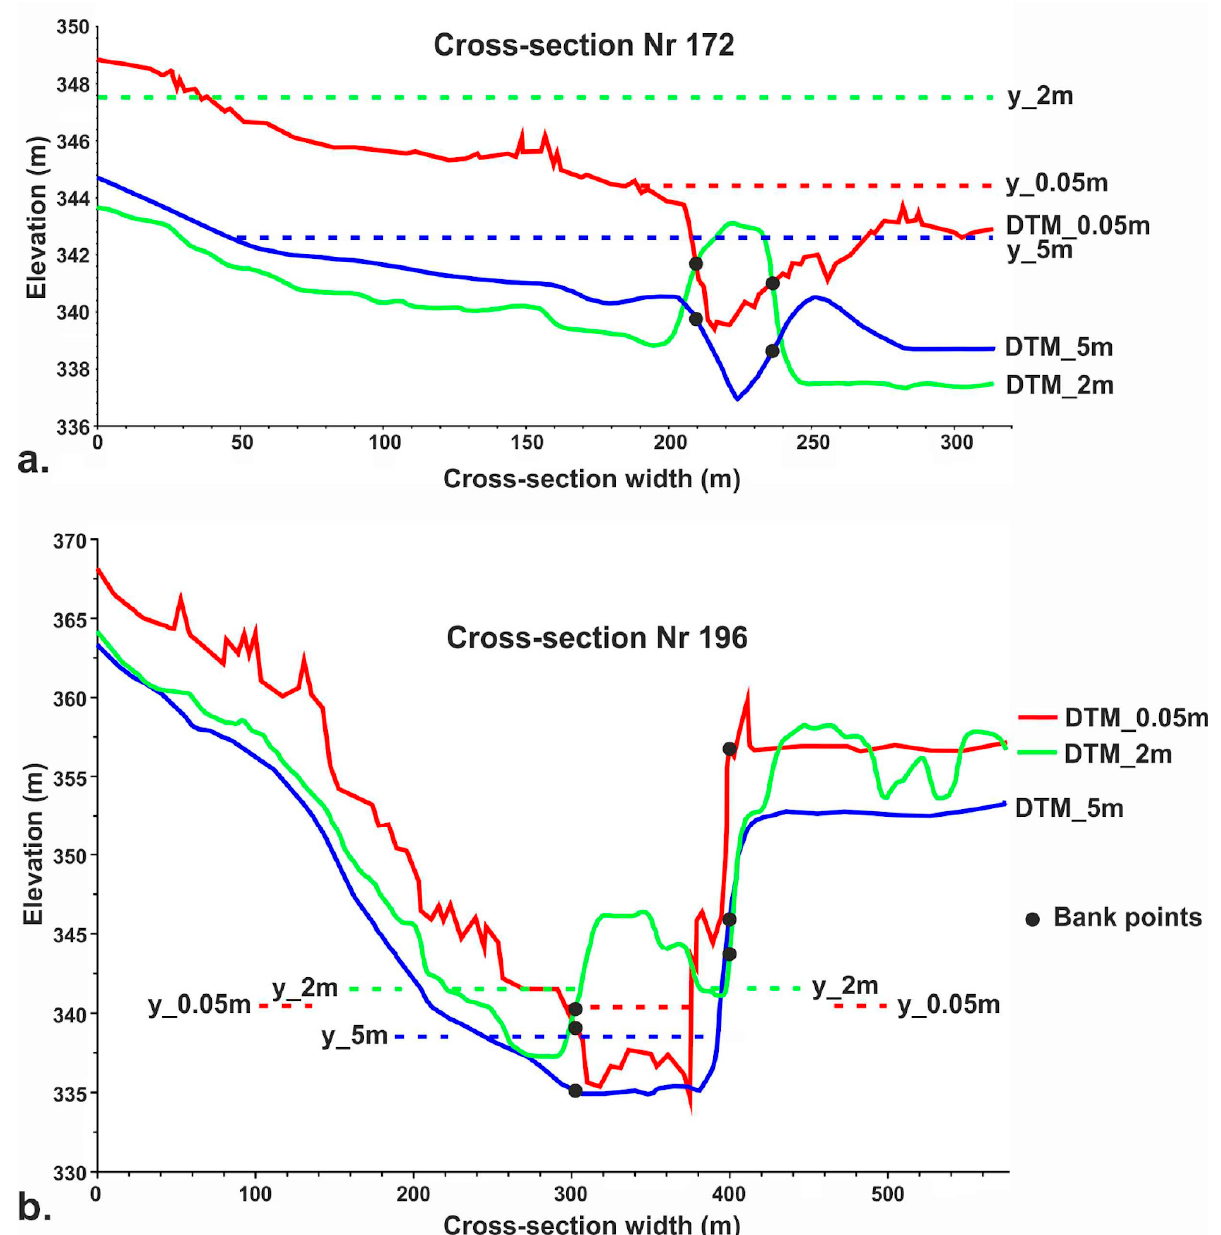
Figure 14. The geometry of the three versions of ( a ) cross-section 172 and ( b ) cross-section 196; (see SM23) as derived from DTM_5 m (blue), DTM_2 m (green), and DTM_0.05 m (red). DTM_5 m captures the general geometry, whereas DTM_2 m fails to delineate the main channel.